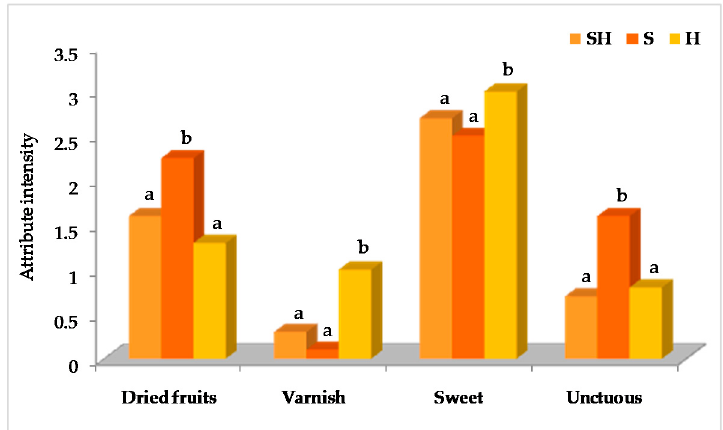
Figure 3. Results of the mean comparison test of the four sensory attributes significantly different in the spirit drinks. For each attribute, columns with different letters (a, b) are significantly different according to Scheffé’s